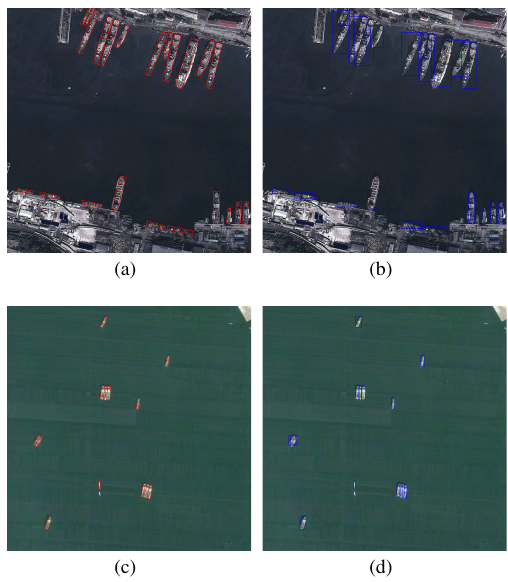
Figure 5. Qualitative ship detection results of our method in the forms of the rotated bounding boxes (a and c) and the regular rectangular bounding boxes (b and d). The scenes include ports (a and b) and sea surfaces (c and d). We note that the small ships are not taken into consideration on the two